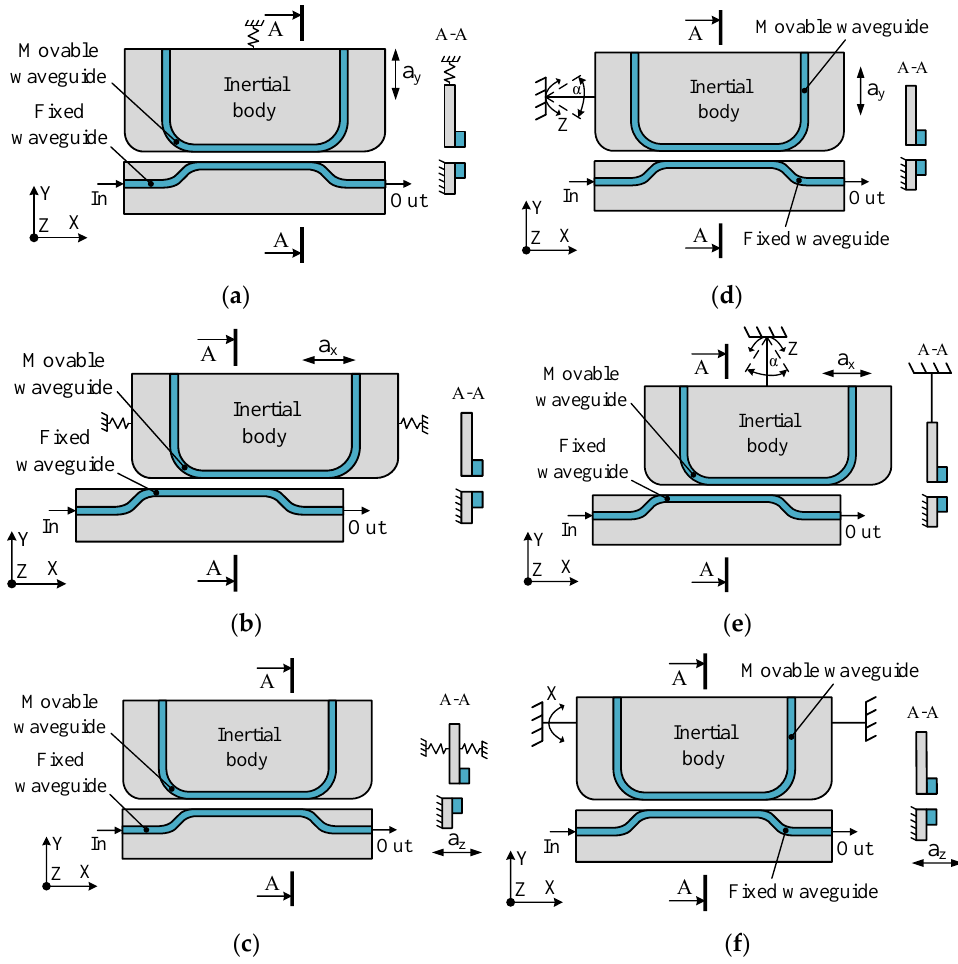
Figure 4. Functional schemes of the MOEM-accelerometer with single-plane waveguides. ( a ) Scheme 1, displacement along Y axis (gap change); ( b ) Scheme 2, displacement along X axis (length change); ( c ) Scheme 3, displacement along Z axis (overlap change); ( d ) Scheme 4, displacement around Z axis (gap change); ( e ) Scheme 5, displacement around Z axis (length change); ( f ) Scheme 6, displacement around X or Y axis (overlap change).